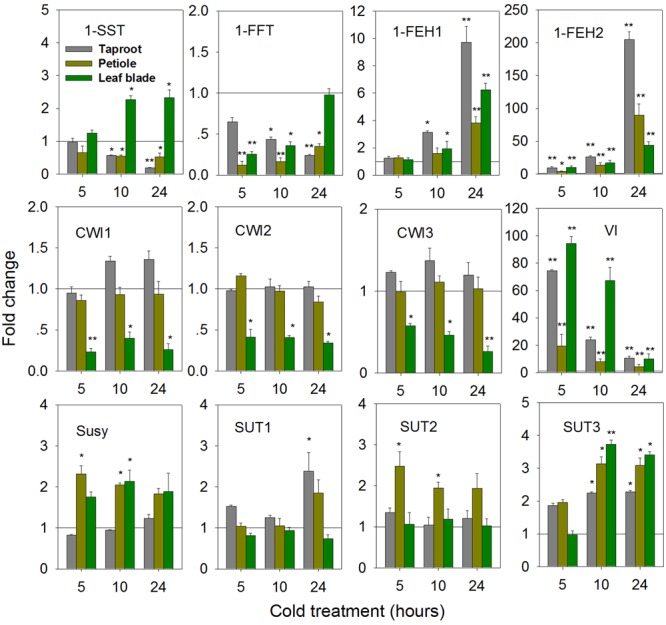
Impact of cold treatment (6°C) on transcript levels of FAZYs (1-SST, 1-FFT, 1-FEH1 and 1-FEH2), sucrose-cleaving enzymes (CWI1-3, VI, Susy) and sucrose transporter isoforms (SUT1-3) in leaf blades, petioles and taproots of 6-week old chicory seedlings. Seedlings were transferred to cold room (6°C), while control plants were kept at 25°C. Transcript levels were determined by qPCR and normalized against the expression of RPL19. Displayed values are means ± SD of three independent experiments. Fold change for cold treatment was calculated relative to mock samples that were set to 1 as indicated with a horizontal line (fold > 1.0, expression induced; fold < 1.0, expression suppressed). Asterisks represent significant differences as determined by Student’s t-test (∗P < 0.05; ∗∗P < 0.001).